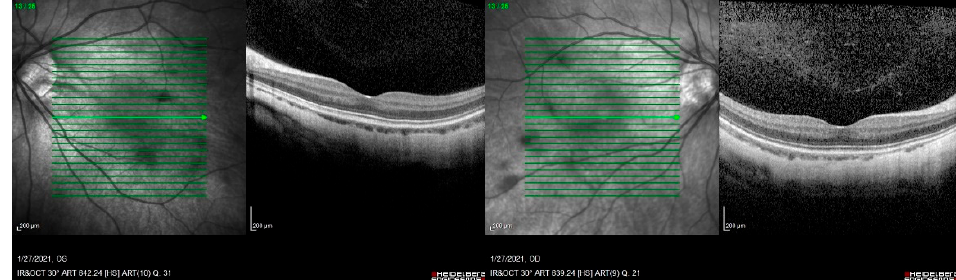
Figure 4. Macular OCT with central staphyloma, from left to right OD and OS. Patient from family OFT-0047.